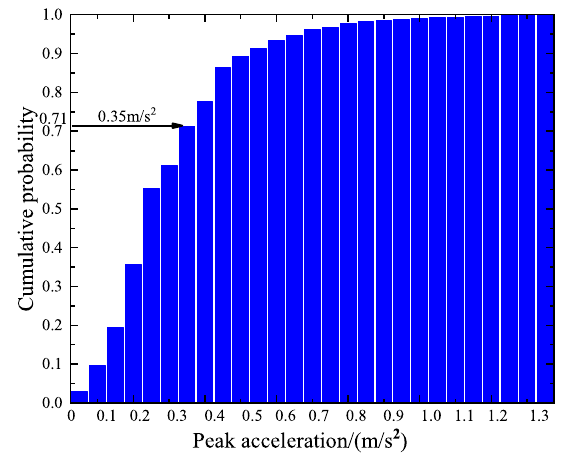
Fig. 12 Cumulative probability as result of MC